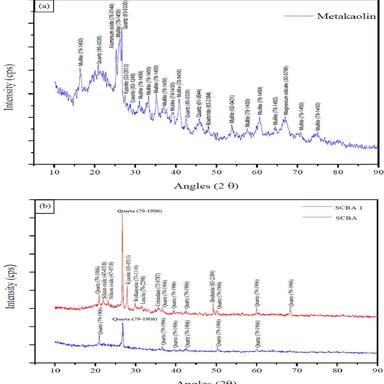
XRD analysis of (a) Metakaolin (b) SCBA & SCBA 1.